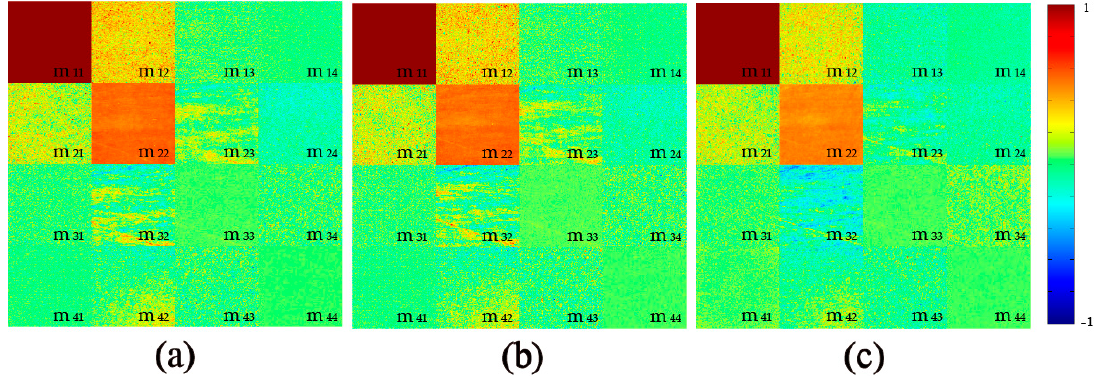
Figure 1. 2D images of Mueller matrices of silk sample washed by fabric softener: ( a ) before washing; ( b ) after the third washing; ( c ) after the sixth washing. The color bar is from − 1 to 1 for the m11, m22, m33, and m44, and from − 0.1 to 0.1 for other elements.